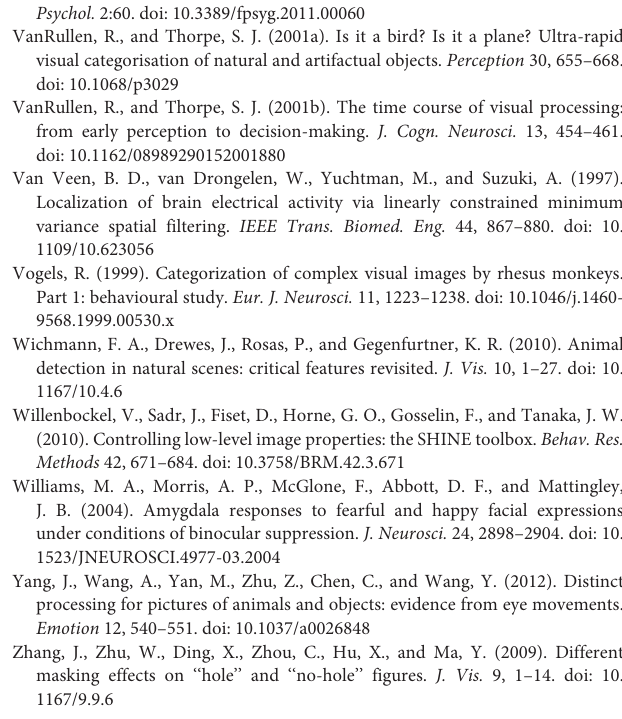
defined right occipital and fusiform ‘‘face areas’’ discriminate novel from visually familiar faces. Neuroimage 19, 877–883. doi: 10.1016/s1053-8119(03) 00105-8 Sergent, C., and Dehaene, S. (2004). Is consciousness a gradual phenomenon? Evidence for an all-or-none bifurcation during the attentional blink. Psychol. Sci. 15, 720–728. doi: